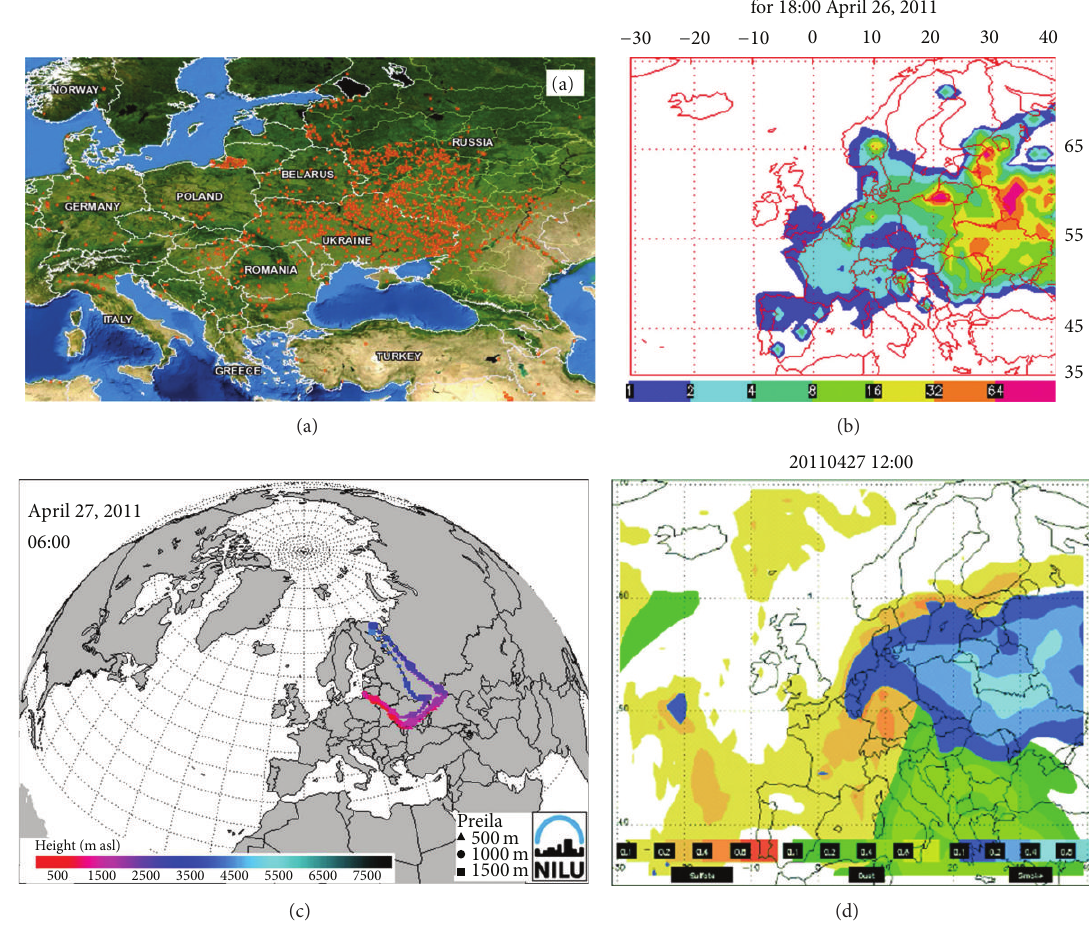
Figure 2: Active fires detected during April 24–30, 2011 during high BC concentration event: (a) by the MODIS Rapid Response System, ((b), (d)) sulphate, dust, and smoke surface concentration ( 𝜇 gm −3 ) for 18:00 April 26 2011, and (c) 7-day air mass backward trajectories to Preila (at 500, 1000, and 1500m AGL) during the event of grass fires.